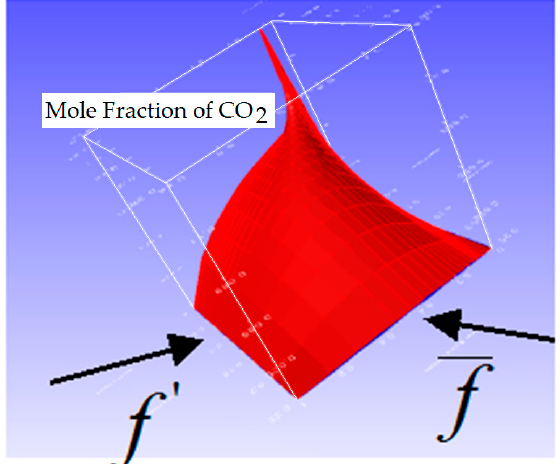
Figure 20. An example of the distribution of a two-parameter function of carbon dioxide formation in a fuel combustion process.